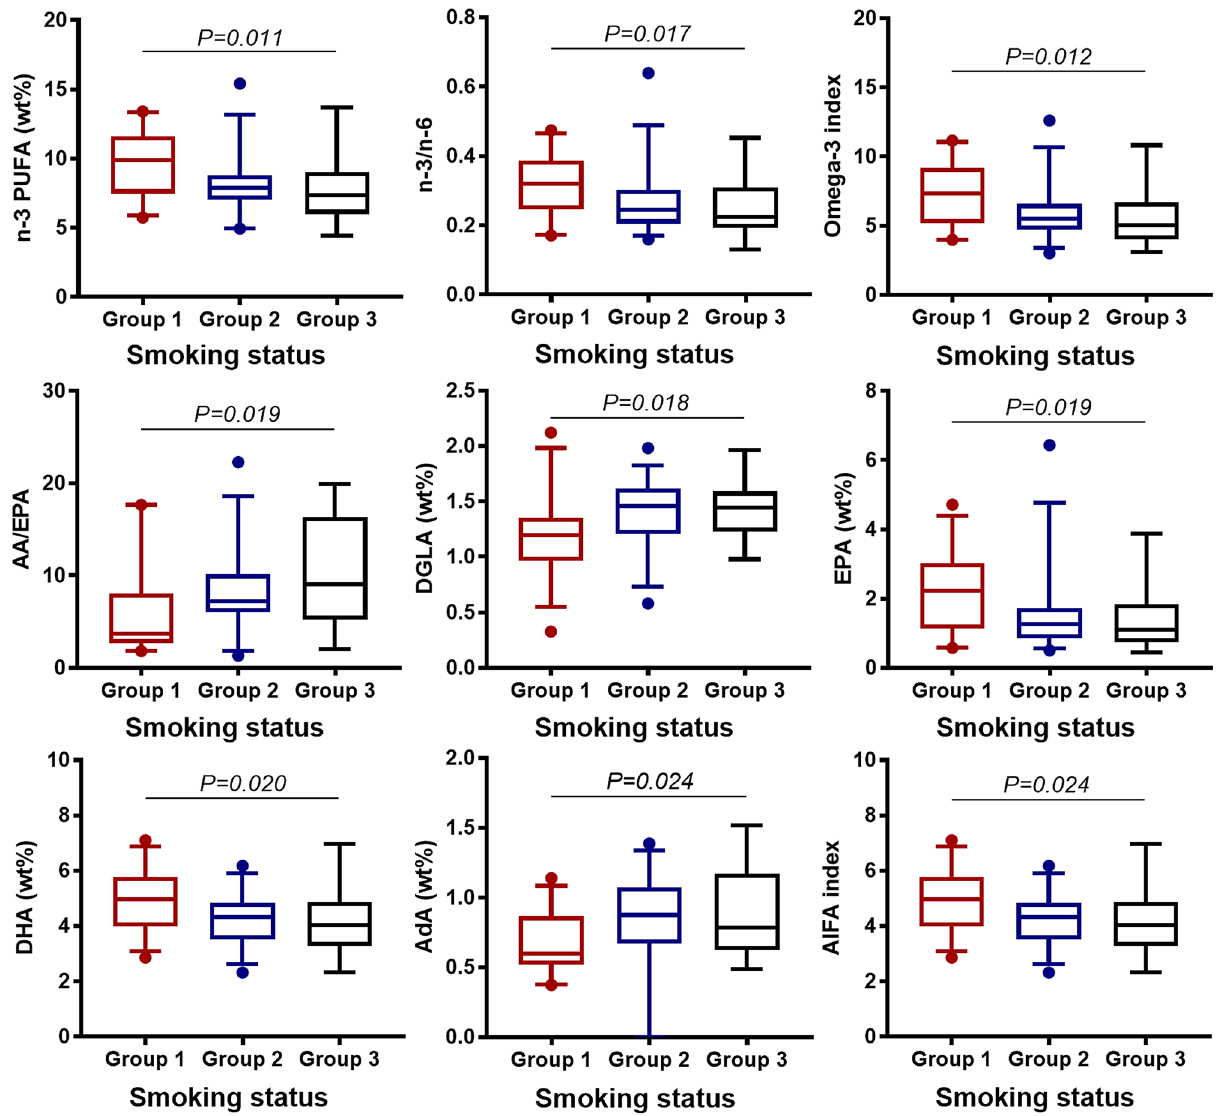
Figure 5. Association between whole blood FA and smoking status in RA patients (N = 78). Boxplots show FA, FA indices and -ratios significant associated with smoking status: group 1 = never smokers (N = 29, coloured in red), group 2 = former smokers (N = 35, coloured in blue), group 3 = current smokers (N = 14, coloured in black). The boxplots show medians, the error bars indicate 5–95% confidence interval. The connectors show statistically significant differences within these groups, P < 0.05. P -values are based on